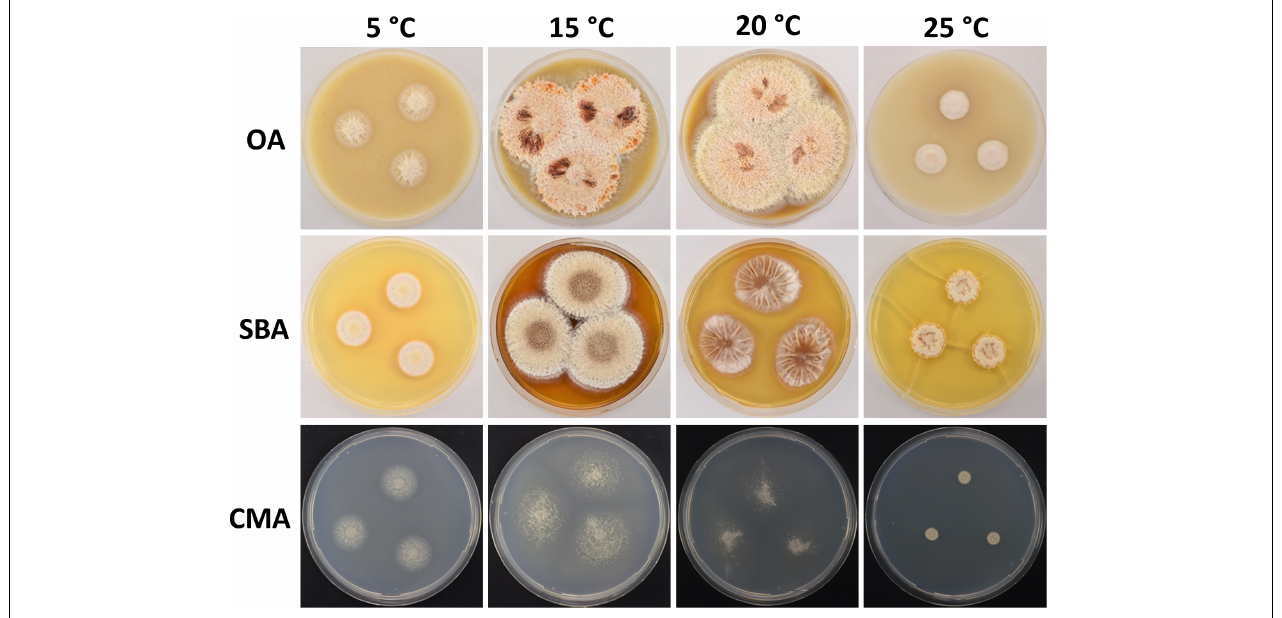
FIGURE 8 | Colony morphology of Pseudogymnoascus lanuginosus sp. nov. grown on OA, SBA, and CMA media at 5, 15, 20, and 25 ◦ C after 28 days of incubation. The cracked agar observed in SBA at 25 ◦ C was not produced by a technical pitfall, but was produced by the growth of the fungus. Apparently,